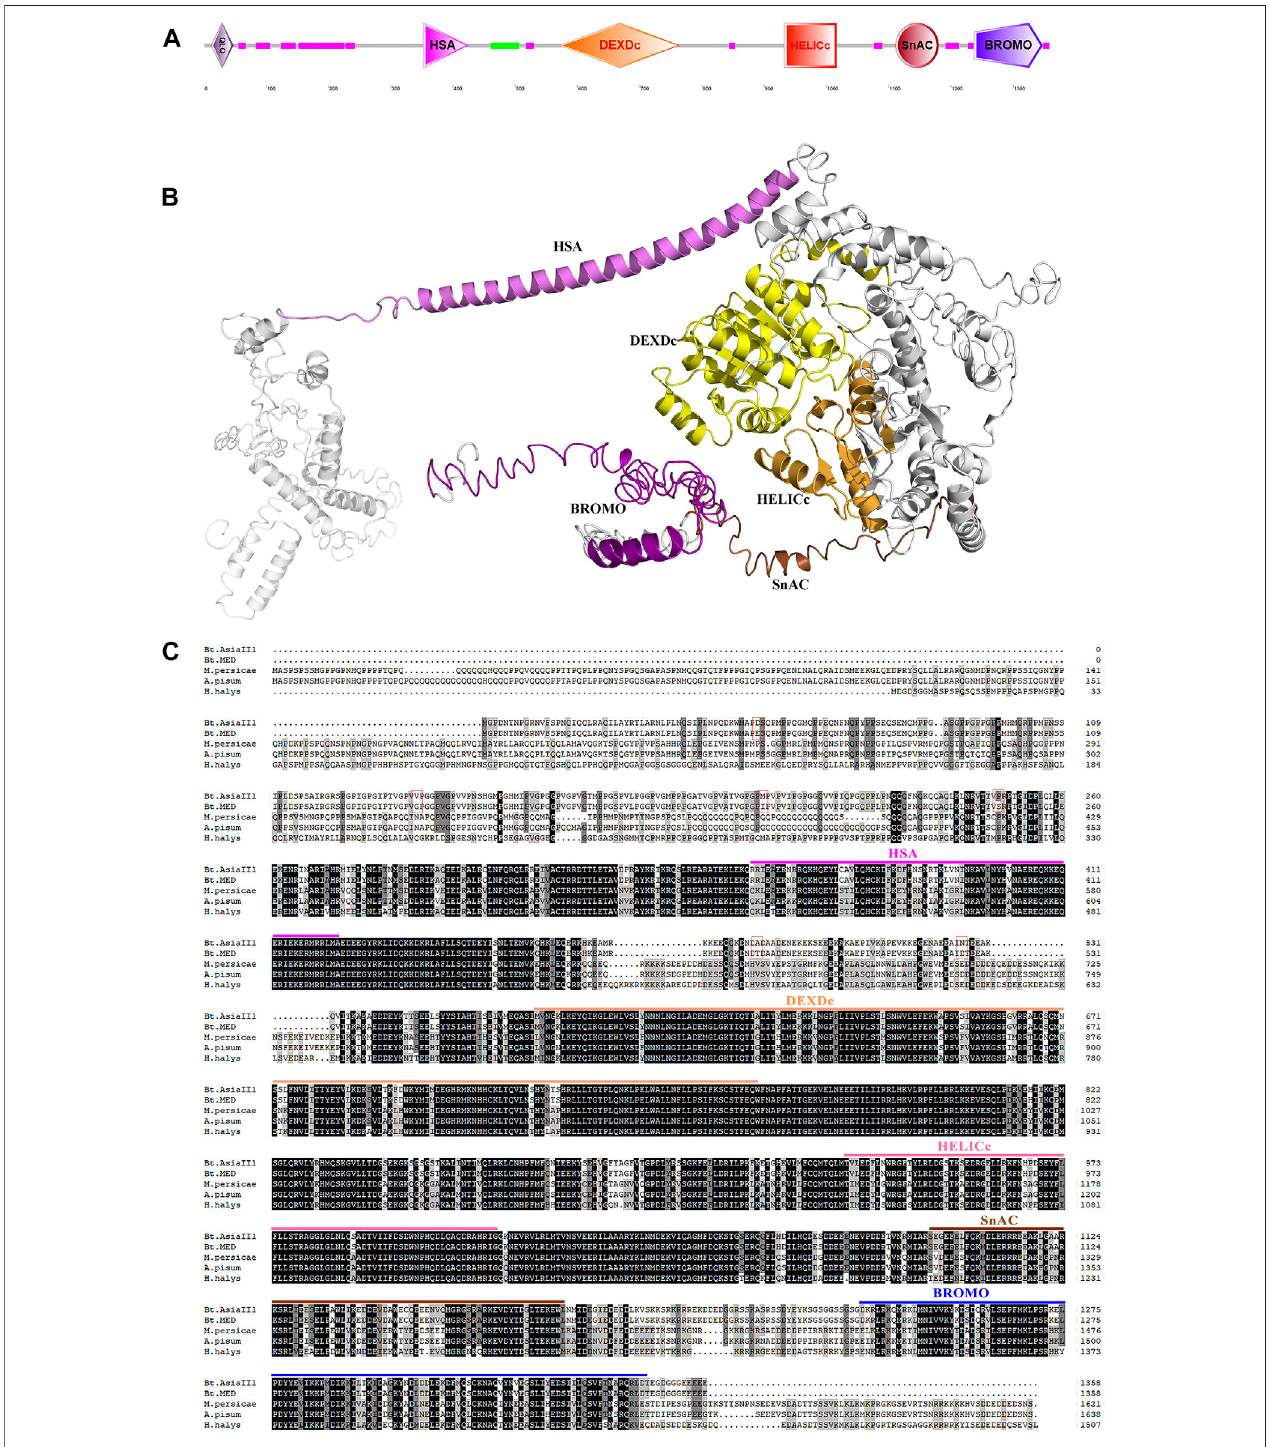
FIGURE2| Conserved domainsofBt-BRM-1in Bemisiatabaci . (A) FunctionaldomainsinBt-BRM-1protein. (B) ThepredictedtertiarystructureofBt-BRM-1. (C) Multiple alignments of the BRM protein from white fl ies and other insects. The conserved domains are highlighted in different colors and the amino acid sites that vary between MED and Asia II 1 are marked with red rectangles. Bt. Asia II 1: Bemisia tabaci Asia II 1; Bt. MED: Bemisia tabaci MED; M. persicae: Myzus persicae (XP_022166801.1); A. pisum: Acyrthosiphon pisum (XP_001947872.2); and H. halys: Halyomorpha halys (XP_014292008.1).